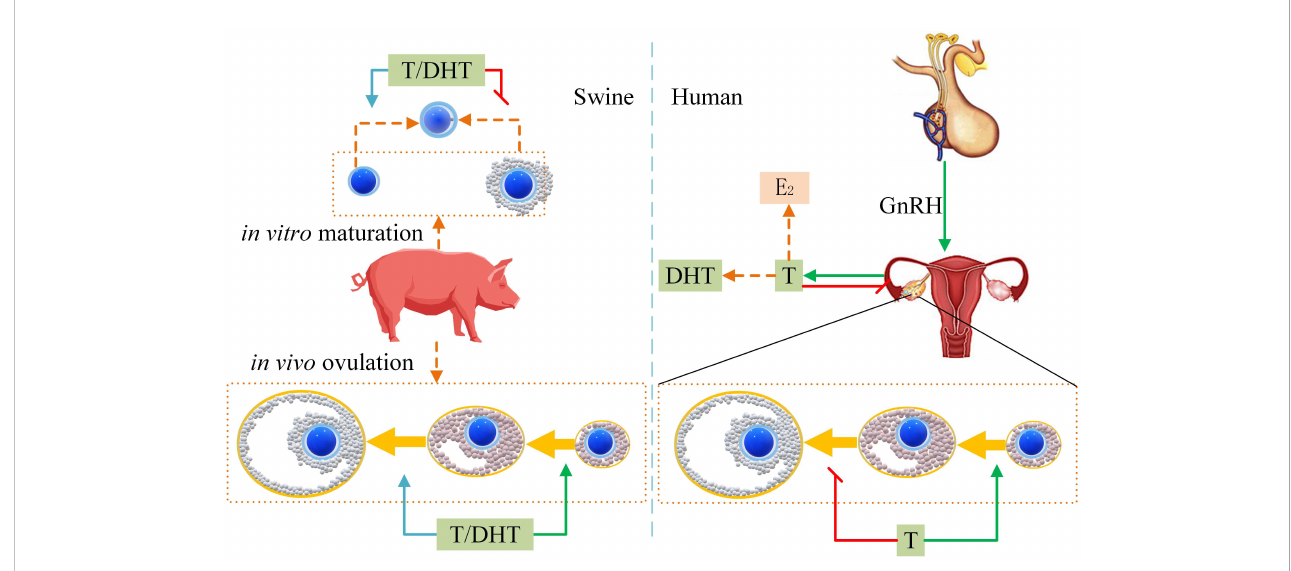
FIGURE 5 Proposed mode of androgens effect on sow reproduction. The green arrow indicates improvement. The red fl at-end segment represents a decrease. The left side indicates that T/DHT promotes pig ovulation in vivo . T/DHT inhibits COCs in vitro maturation and promotes DOs maturation. The right side shows that human T inhibits the development of antral follicles to mature